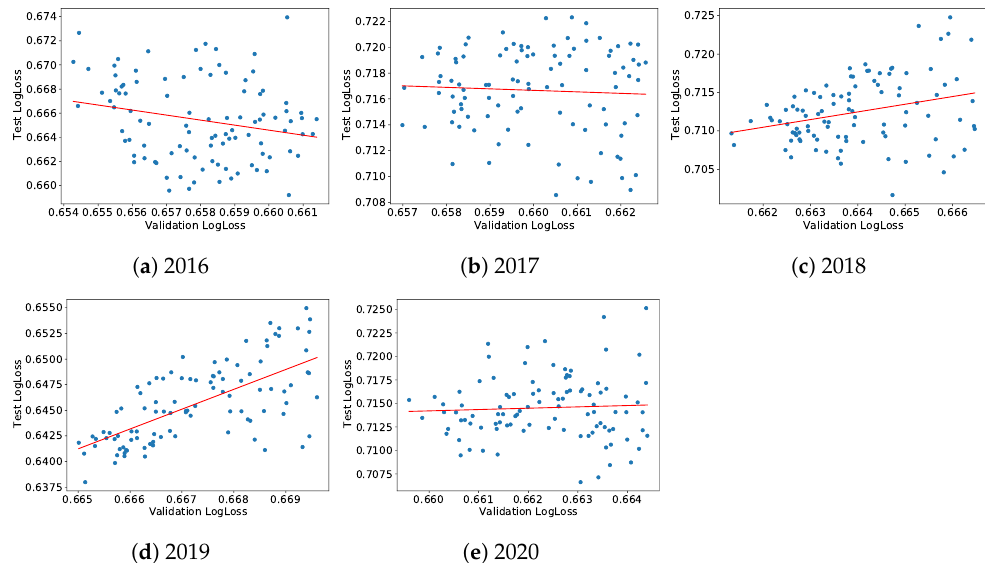
Figure A1. Company-wise cross-validation: test set cross-entropy versus validation cross-entropy of the 100 best models of the random hyperparameters search for a target computed using the Fama–French 3-factor model. Table A1. Dependence measures between the cross-entropy losses in the validation and test sets for the 100 best models of the random hyperparameters search and for a target computed using the Fama–French 3-factor model.